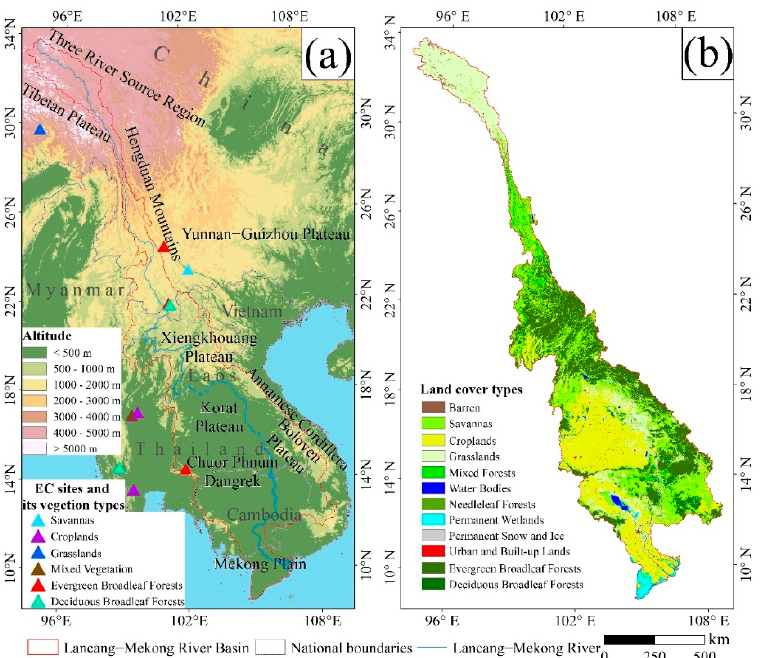
Figure 1. Basic geographic information of the Lancang–Mekong River Basin (LMRB): ( a ) elevation and distribution of EC sites; ( b ) land cover map from 2019.